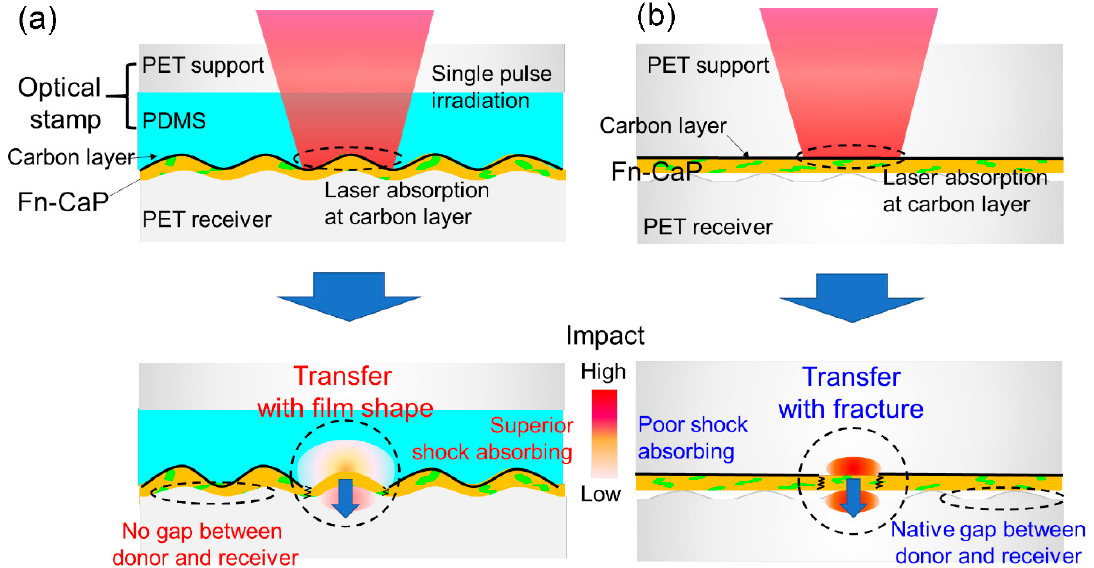
Figure 4. A model for the Fn-CaP film transfer by ( a ) LIFTOP and ( b ) LIFT. A single nanosecond laser pulse was irradiated on ( a ) the Fn-CaP / C / PDMS / PET donor sample through the carbon-coated optical stamp or ( b ) the Fn-CaP / C / PET donor sample through the carbon-coated PET support, leading to strong laser absorption at the carbon sacrificial layer and the subsequent donor film transfer.